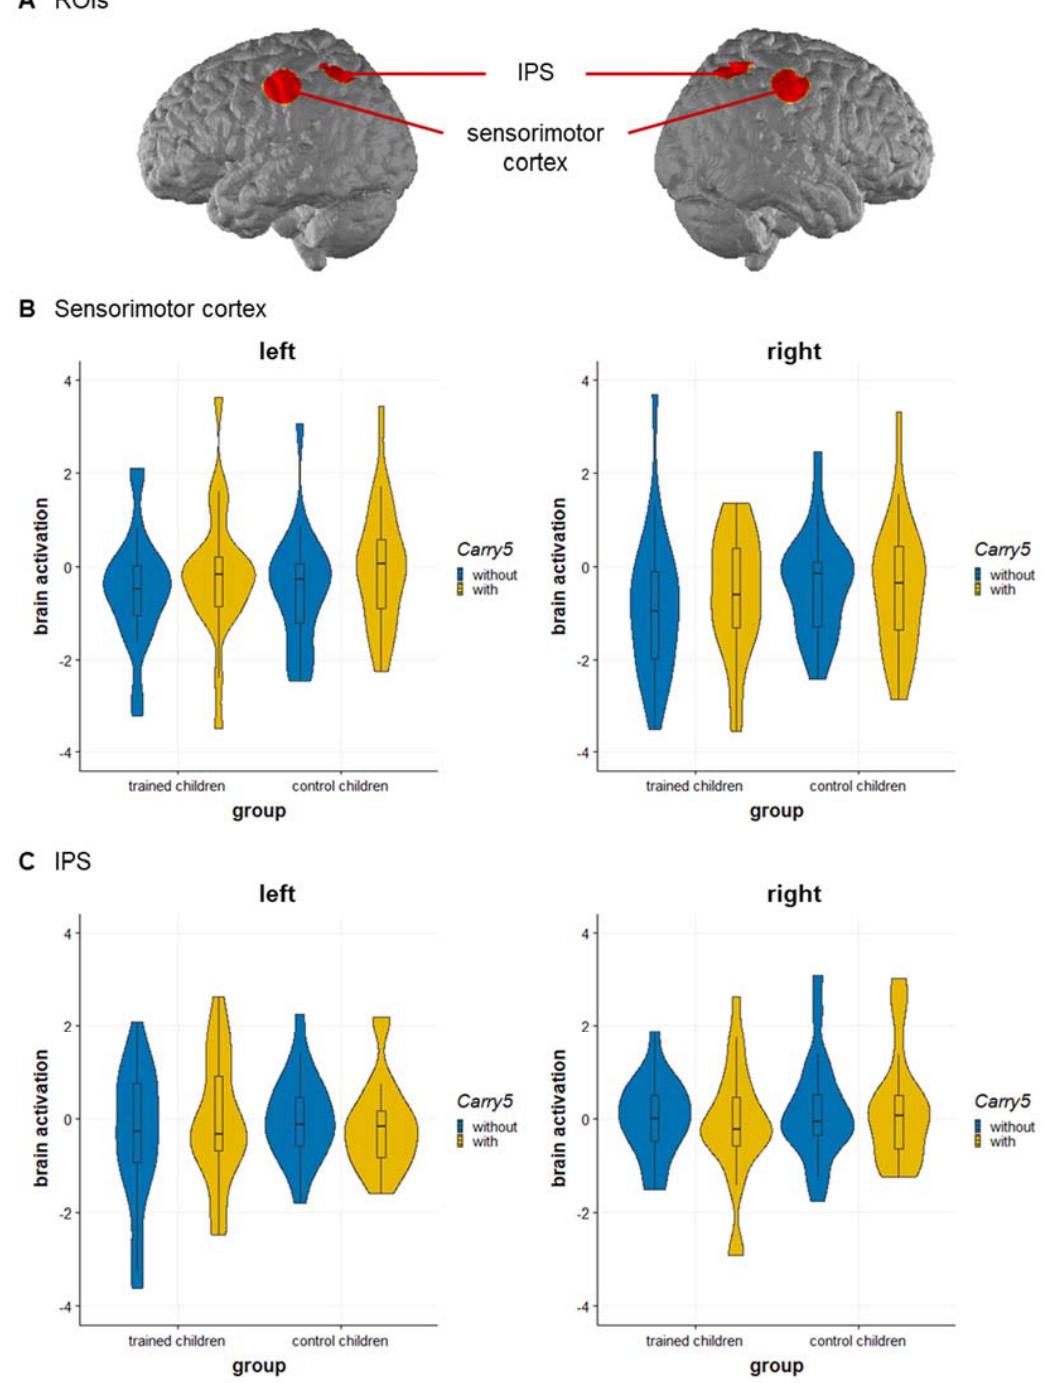
Figure 3. Neural activation of the sub ‐ base effect in single ‐ digit addition. ( A ) ROIs: Sensorimotor cortex and IPS on the left and right hemisphere. ( B ) Sensorimotor cortex: Trained children showed a subbase ‐ 5 effect in the right sensorimotor cortex and control children in the left sensorimotor cortex. ( C ) IPS: IPS activation for trained and control children for the subbase ‐ 5 effect. Violin plots display the kernel distribution of the neural activation within each ROI; box plots include the interquartile range (IQR = 25–75%) with the horizontal line representing the Median . Abbreviation: IPS—intraparietal sulcus.